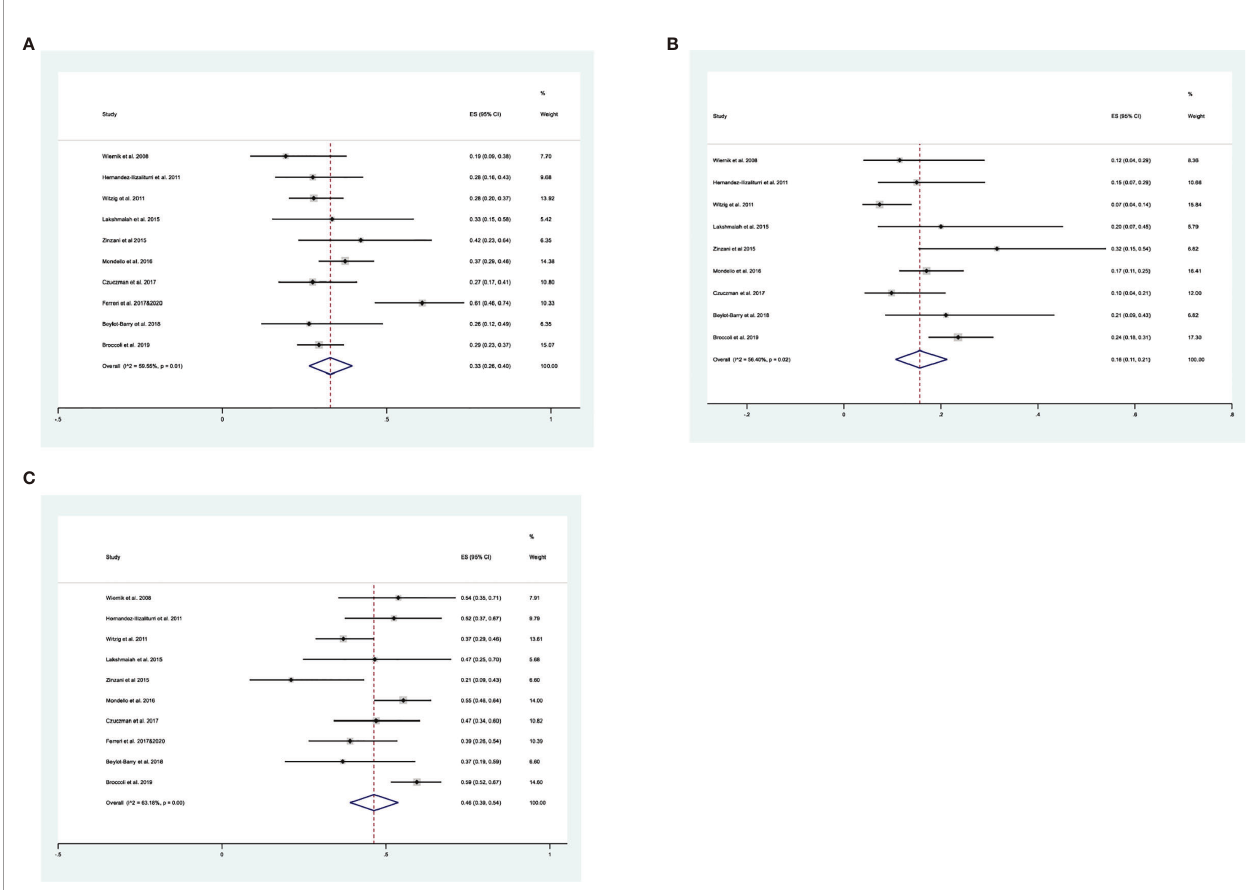
FIGURE 2 | (A) Forest plot of the overall response rates of patients who received maintenance treatment consisting of lenalidomide monotherapy. (B) Forest plot of the complete response rates of patients who received maintenance treatment consisting of lenalidomide monotherapy. (C) Forest plot of progressive disease rates of patients who received maintenance treatment consisting of lenalidomide monotherapy.